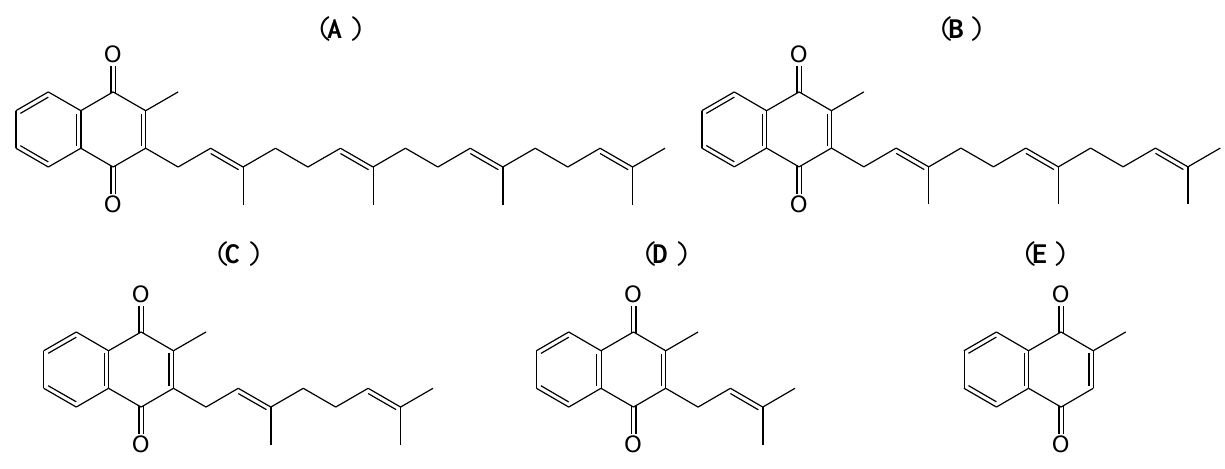
Figure 1. Structures of the VK ( C ) MK-2, ( D ) MK-1, and ( E ) VK